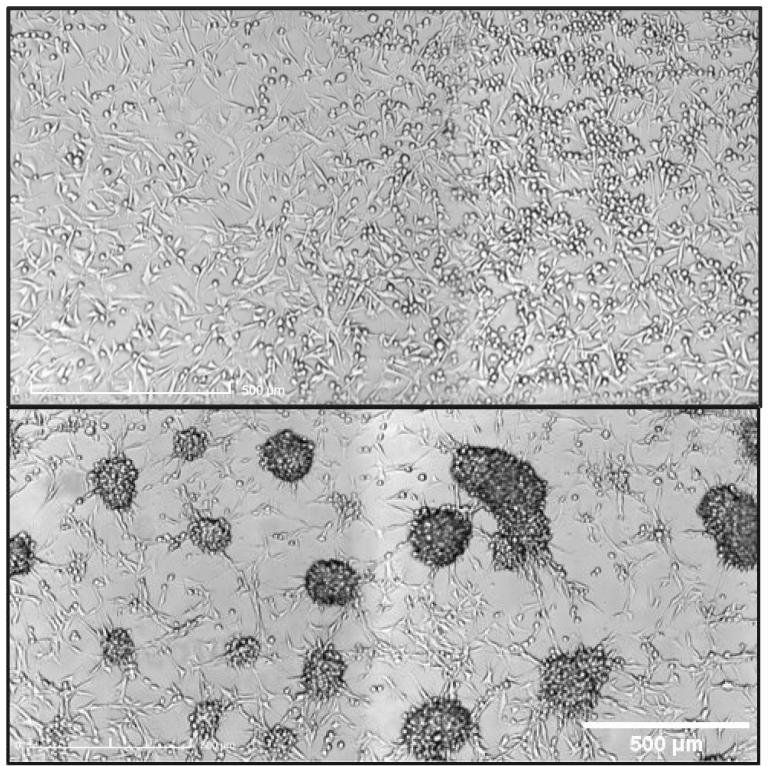
Figure A2. U87 MG seeded at high density (5.0 × 10 5 cells/mL), in a 24-well plate, demonstrating preferential cell–cell adherence. Images captured on the CytoSmart Omni system. Top: Cells 2 h